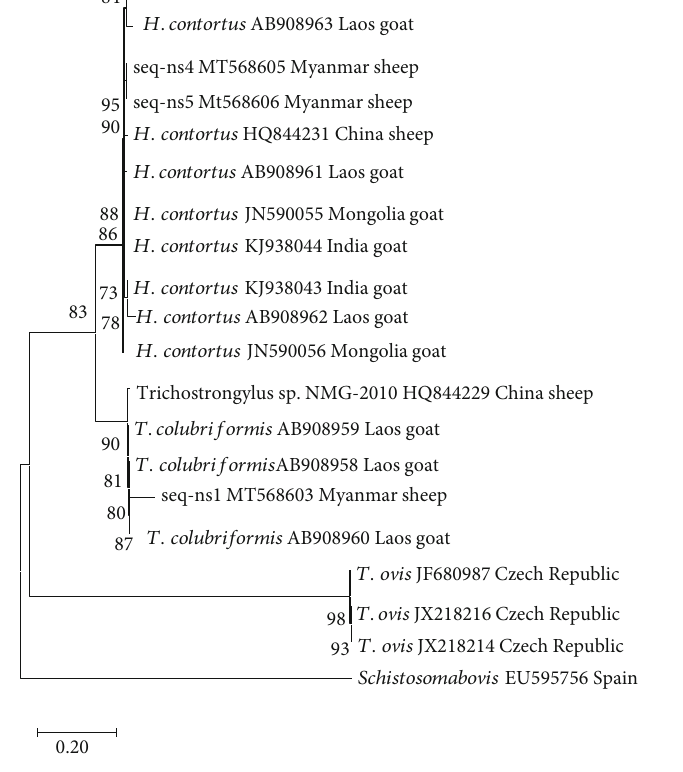
Figure 4: Phylogenetic analysis of ITS sequences of Trichostrongyle nematode by the Neighbor-Joining method using MEGAX. Numbers indicate bootstrap percentages (1000 replicates). The scale indicates the divergence time.